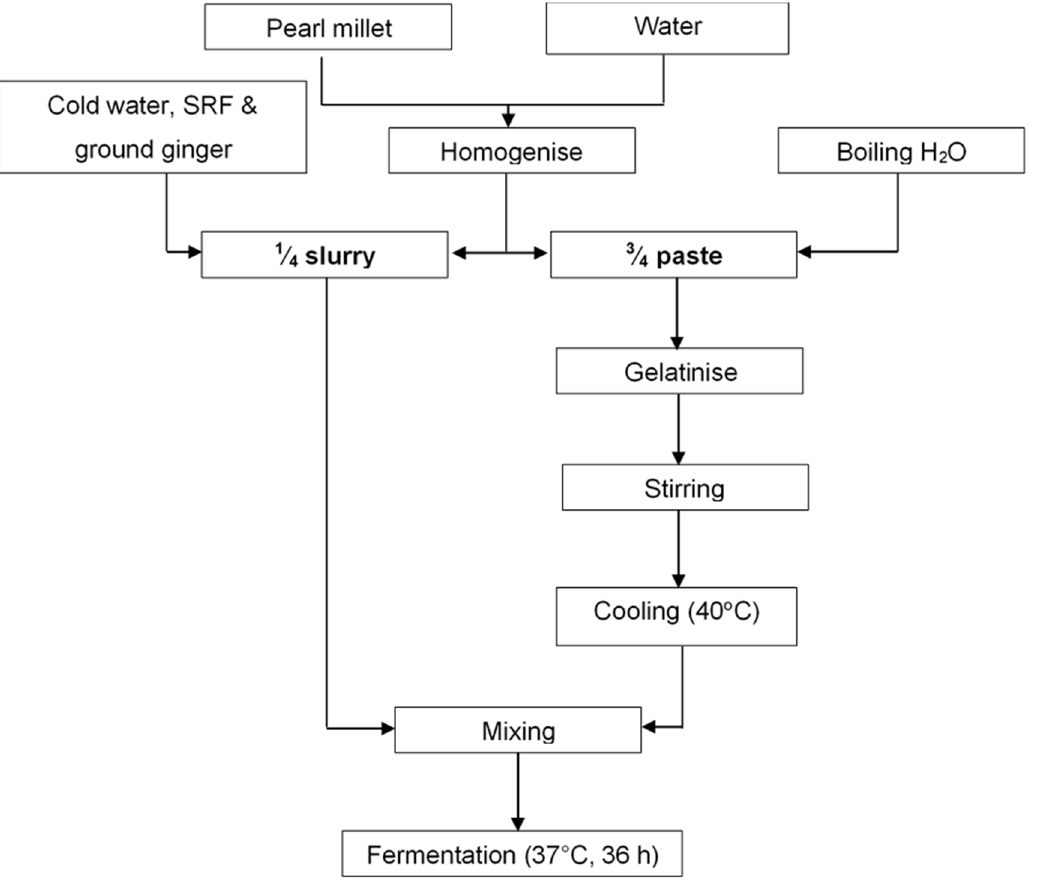
Figure 1. Production process for the pearl millet slurry. SRF—sprouted rice flour.